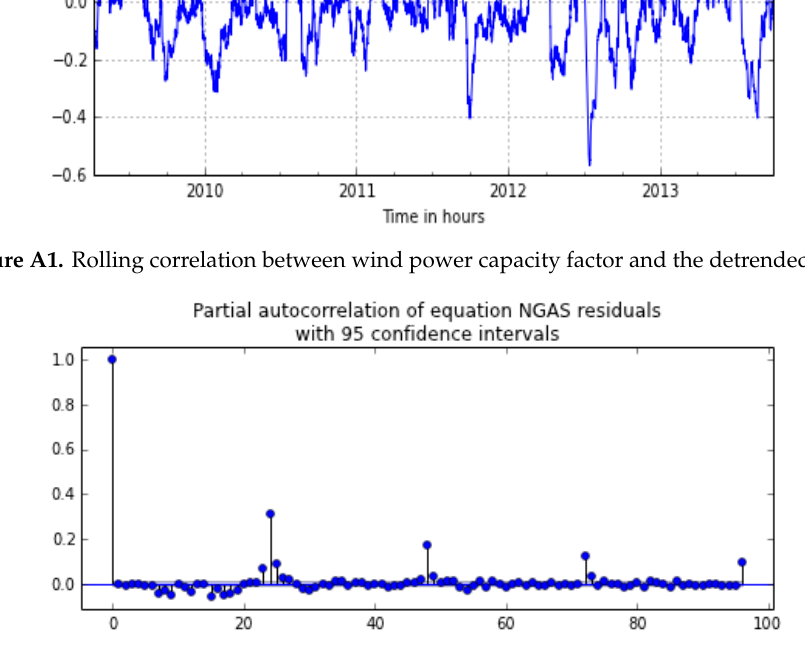
Figure A2. Autocorrelation plot for natural gas-fueled generation.